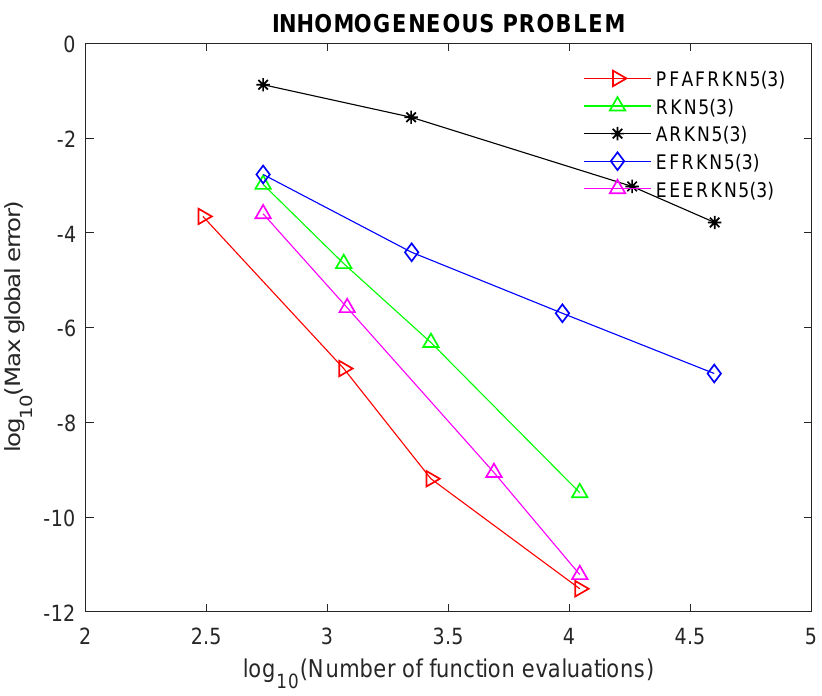
Figure 4. Efficiency curves corresponding to Problem 4.